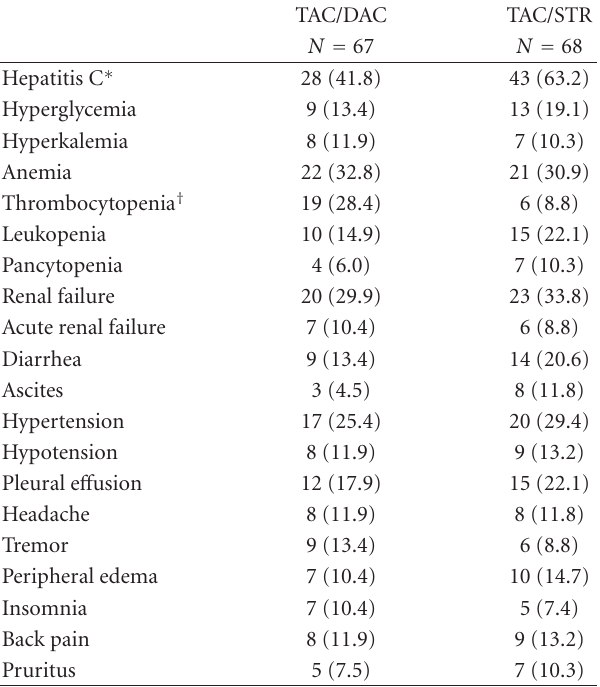
Table 4: Incidence of adverse events occurring in ≥ 10% in either arm of full analysis set and with a significant di ff erence between treatment arms, no.